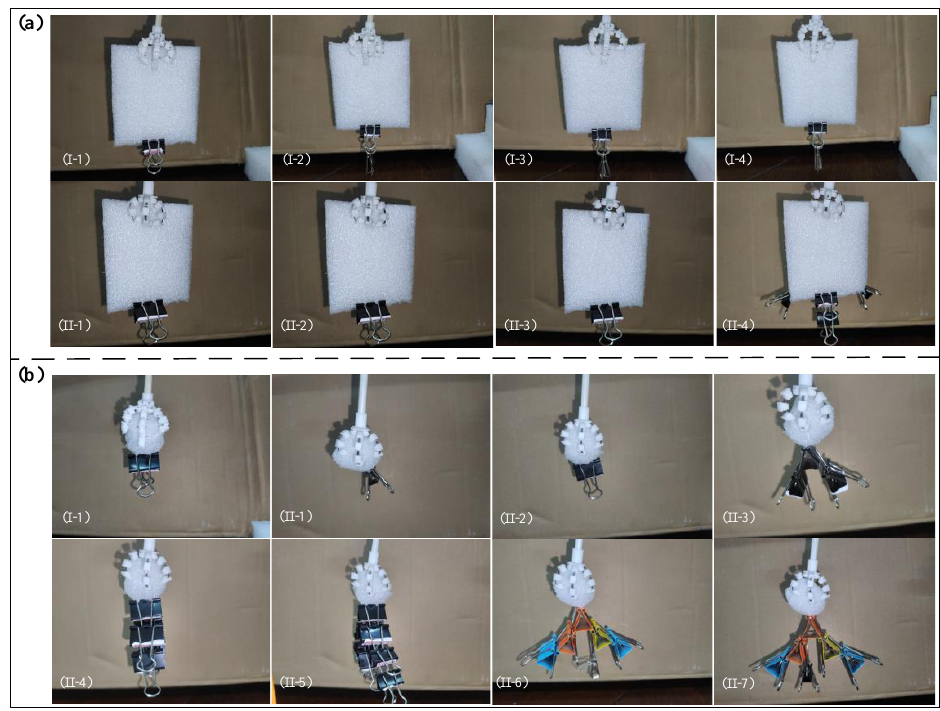
Figure 11. Load performance experiments of the two gripping mechanisms. ( a ) The load was ap- plied to a rectangular base of 1.89 g for counterweight, (I-1) – (I-4) for the articulated gripping mech- anism in order of 2.78 g, 3.4 g, 4.03 g, 4.35 g, (II-1) – (II-4) for the elastic repositioning gripping mech- spherical base for counterweighting, I-1: for articulated gripping mechanism to apply object mass of 24.97 g, (II-1) – (II-7) for resilient repositioning gripping mechanism to apply object mass of 2.78